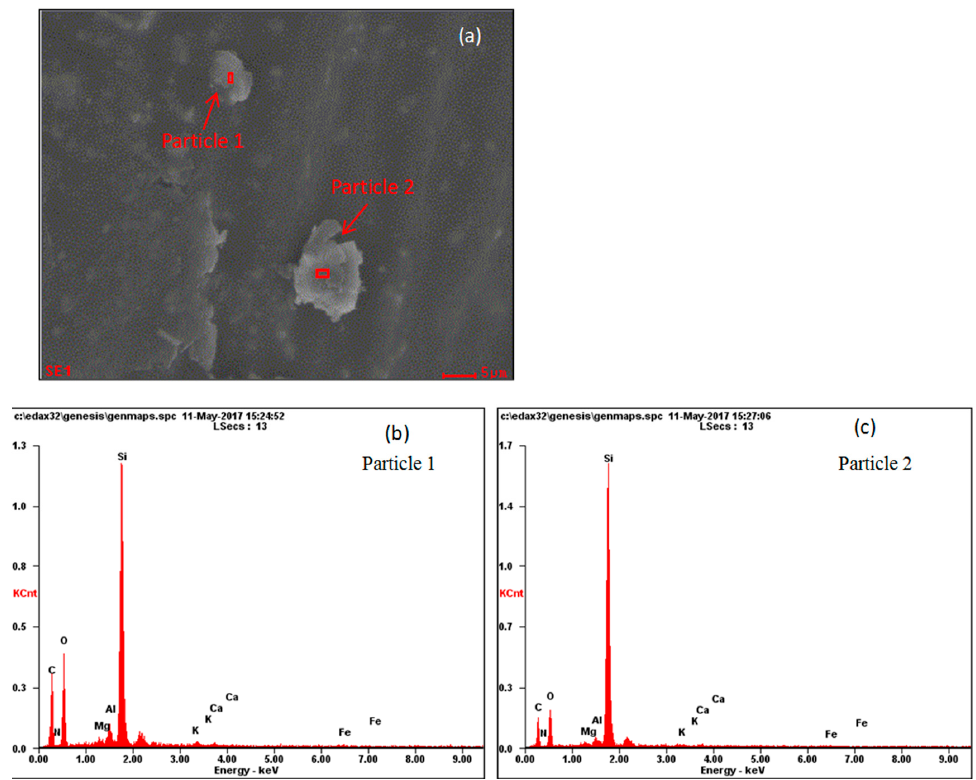
Figure 14. SEM micrographs of Pinus tabulaeformis leaves before dust storm ( a ), and EDS pictures of two PM 10 particles ( b , c ) (×8000).